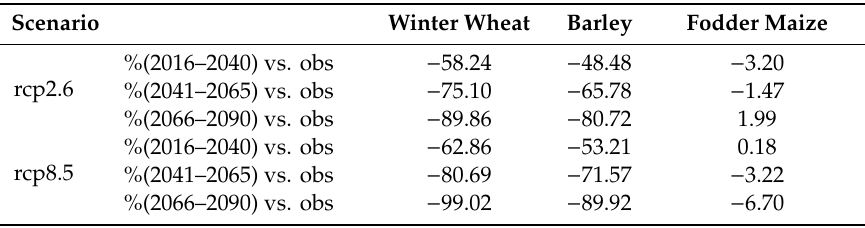
Table 9. Results of the change percentage of the crops under scenarios rcp2.6 and rcp8.5 in